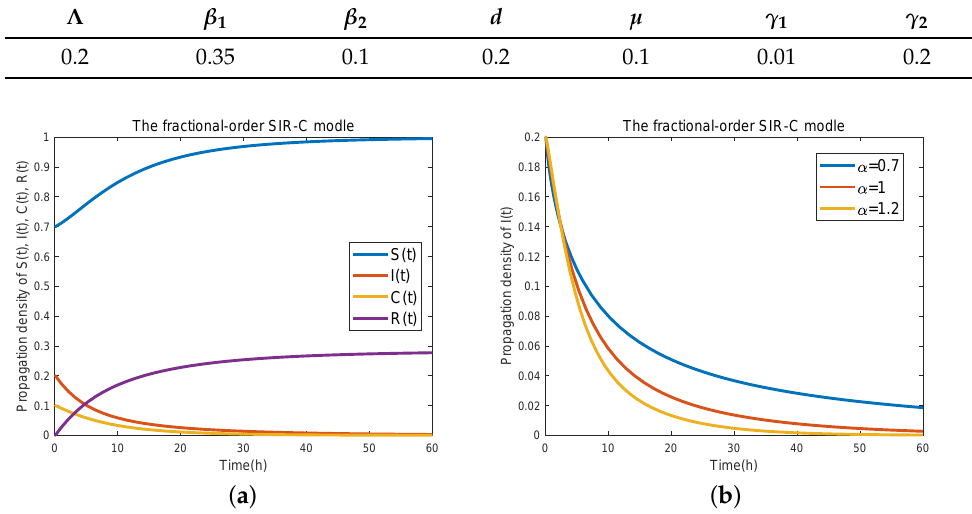
Figure 2. ( a ) Global stability of the rumor-free equilibrium point (RFEP) E 0 = ( 1,0,0 ) , for system (7). ( b ) Consider the effect of different differential orders of α ∈ { 0.7,1,1.2 } on the spread of cyber rumors, for system